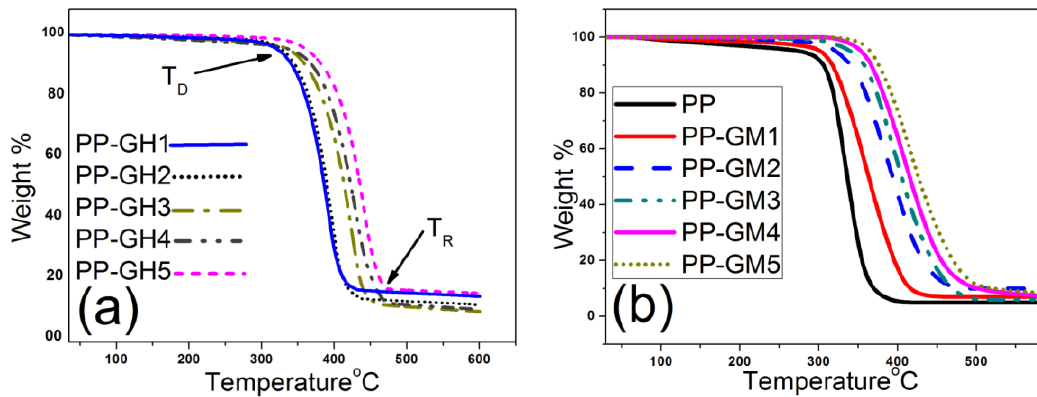
Figure 12. Thermogravimetric analysis (TGA) curves of PP composites incorporated with ( a ) H25 and ( b ) M25. Table 7. TGA results of virgin PP and its composites reinforced with graphene nanoplatelets. Sample T D , ◦